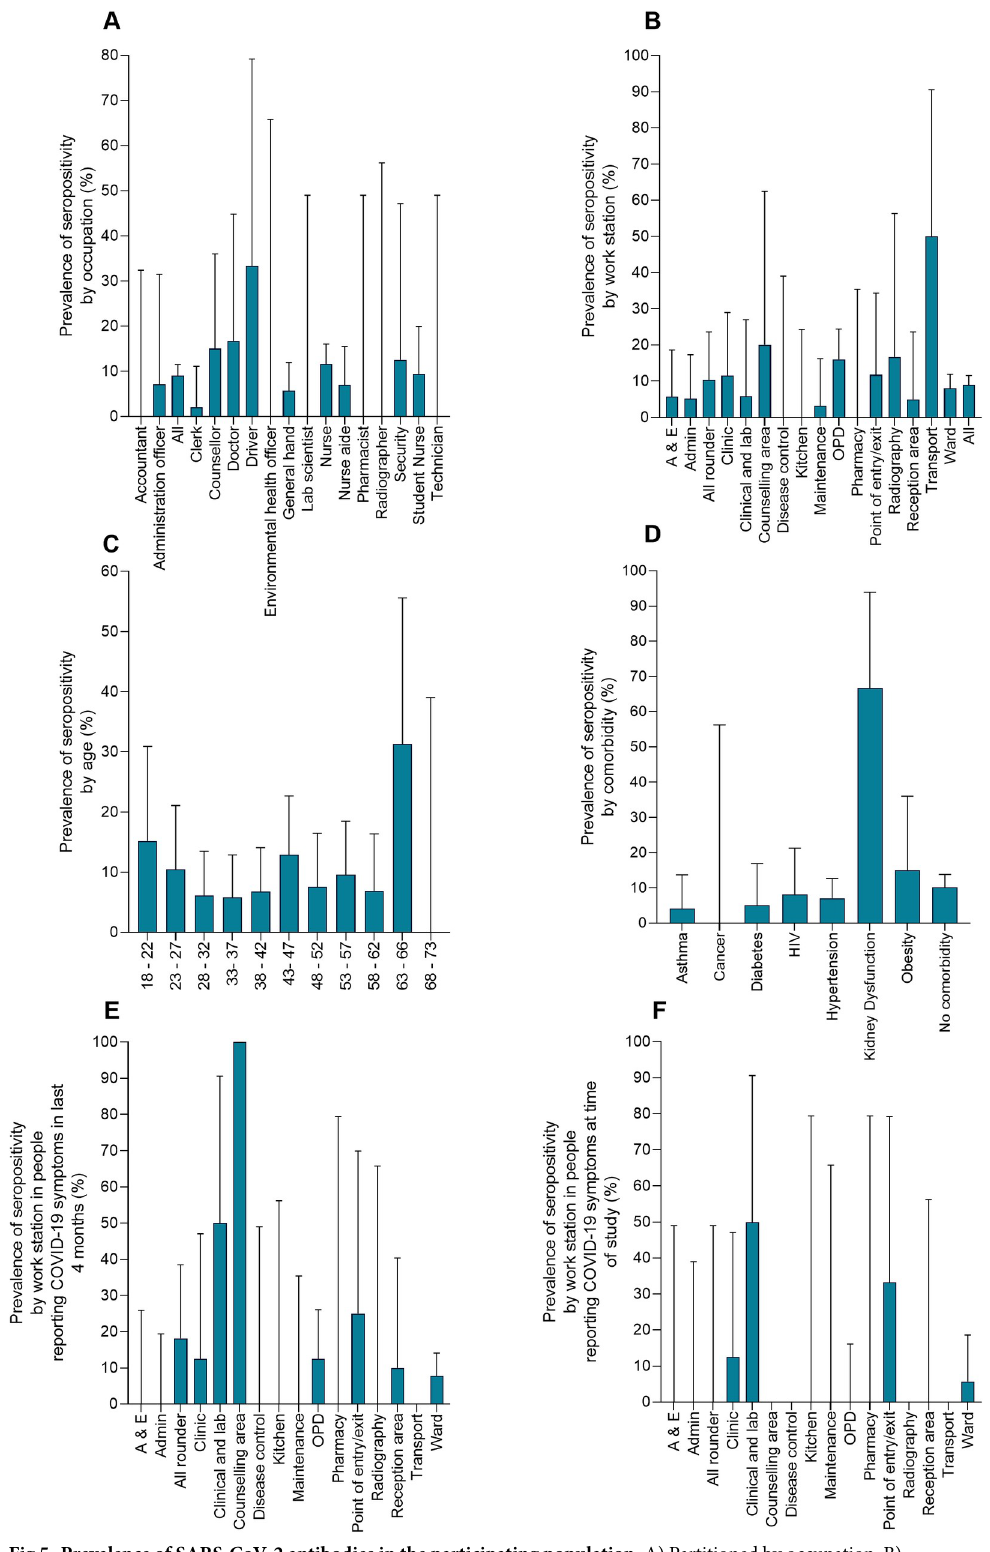
Fig 5. Prevalence of SARS-CoV-2 antibodies in the participating population. A) Partitioned by occupation. B) Partitioned by workstation.C) Partitioned by age group. D) Partitioned by self-reported co-morbidities. E) Partitioned